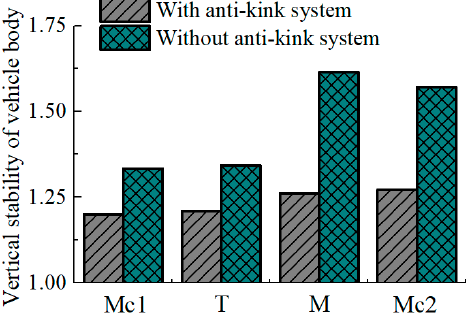
Figure 21. Vertical stability of vehicle body.